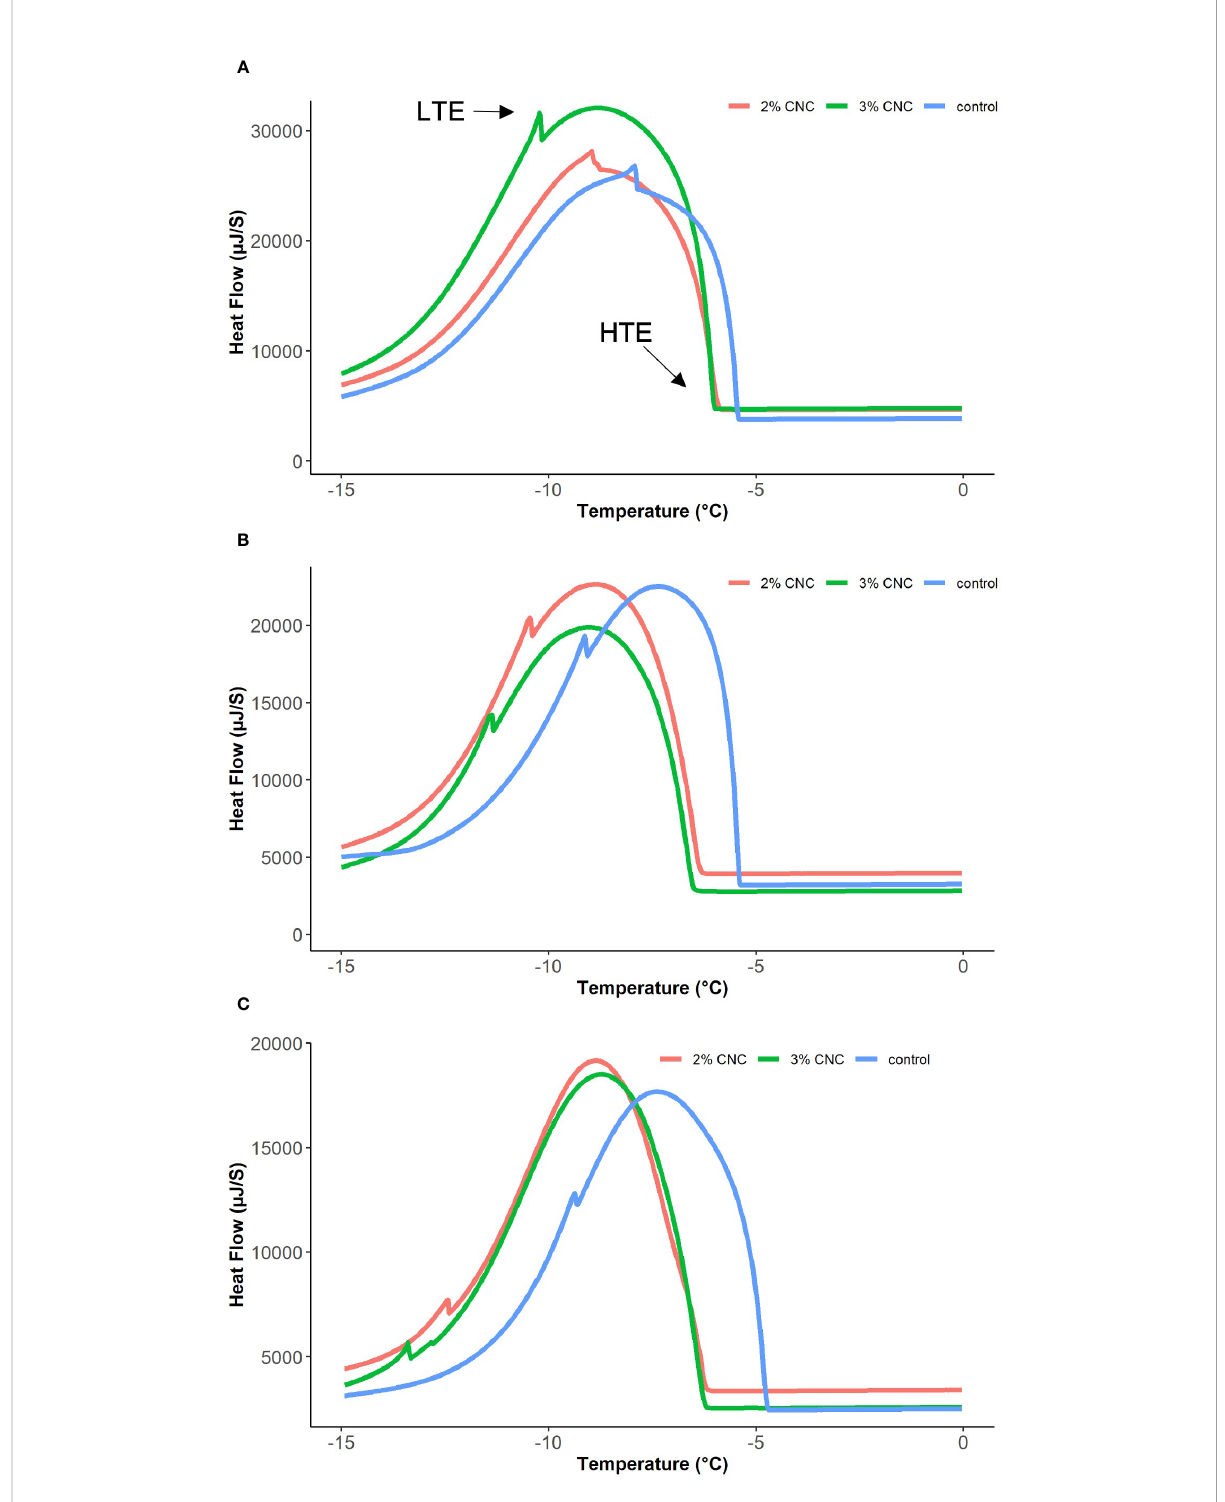
FIGURE 1 Selected heat fl ow curves from digital scanning calorimetry (DSC) of apple buds treated with 2% or 3% (wt) cellulose nanocrystal dispersion or water control, 1 day ( A ), 2 days (B) , and 3 days (C)